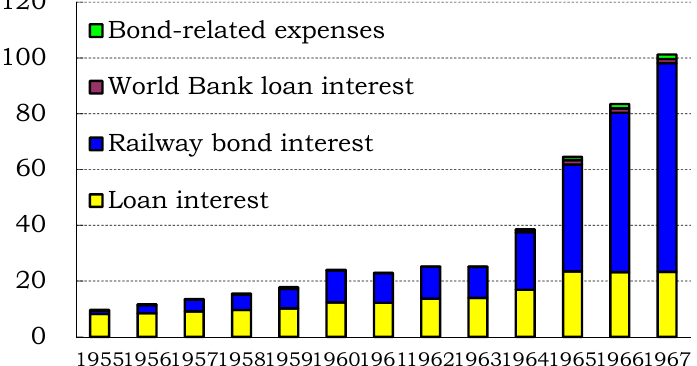
Figure 3. Trends in JNR’s interest and debt handling expenses (in fiscal years) Source: Takahashi (2000, Figure